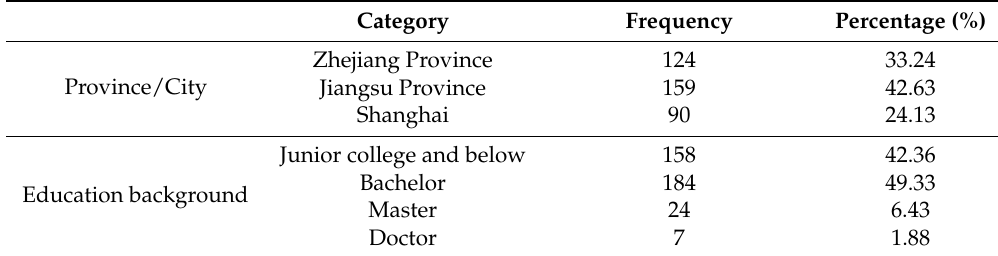
Table 2. Demographics of